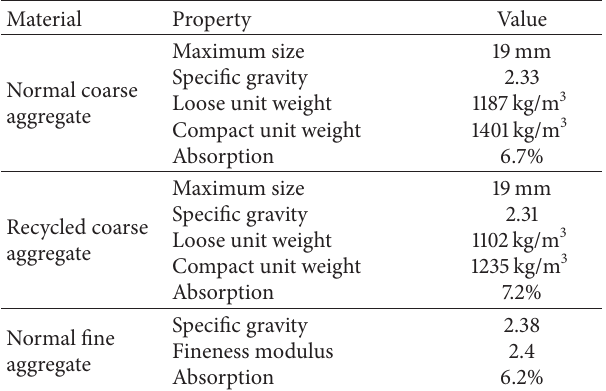
Table 3: Aggregate properties.